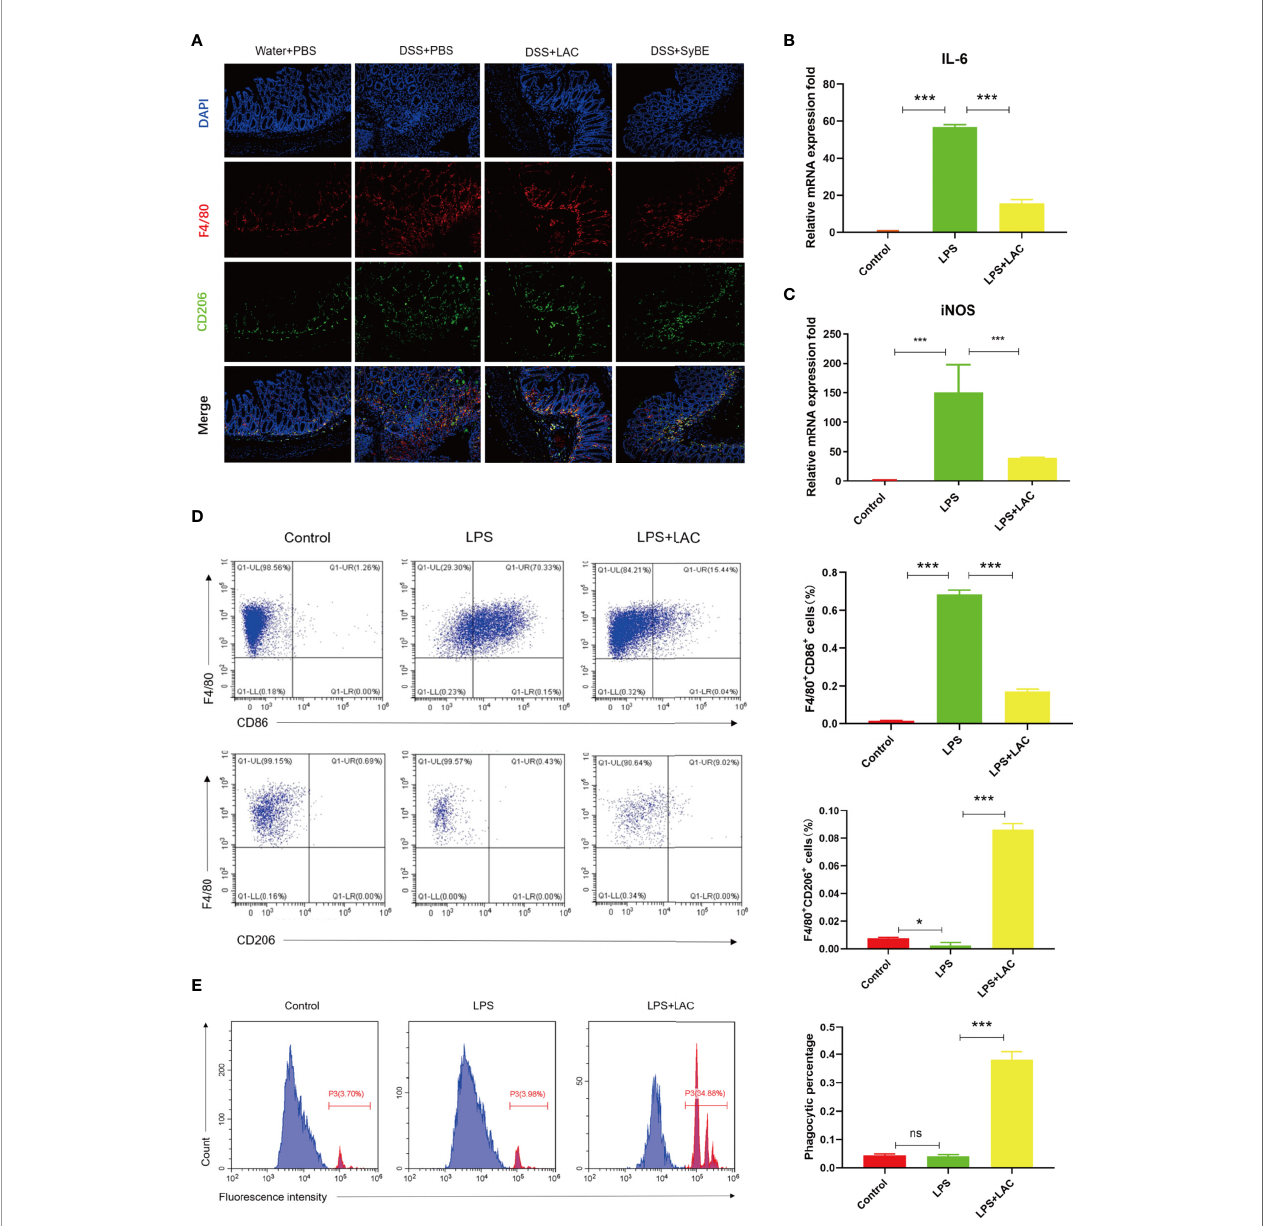
FIGURE 4 | Lactic acid and lactic acid-producing Saccharomyces cerevisiae improved macrophage polarization and phagocytosis. (A) Lactic acid and SyBE enhanced M2 polarization in the colon of colitis mice. (B , C) Lactic acid inhibited the expressions of IL-6 and iNOS in bone marrow-derived macrophages (BMDMs) upon stimulation with lipopolysaccharide (LPS). (D) Lactic acid inhibited the expression of CD86 and promoted the expression of CD206 in BMDMs. (E) Lactic acid promoted the phagocytosis of macrophages. * p < 0.05; *** p < 0.001 vs. the LPS group. ns, no signi fi